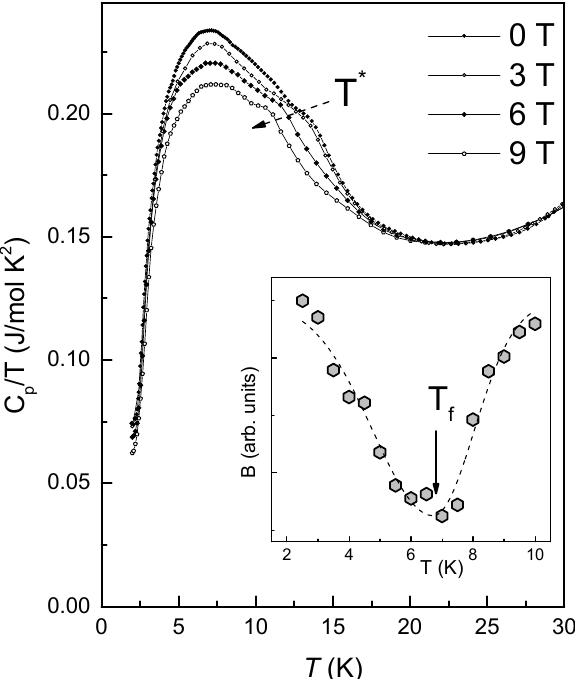
Figure 6. The temperature dependencies of specific heat C p / T ( T ) under various magnetic fields. The inset represents the temperature dependence of parameter B (see in text).